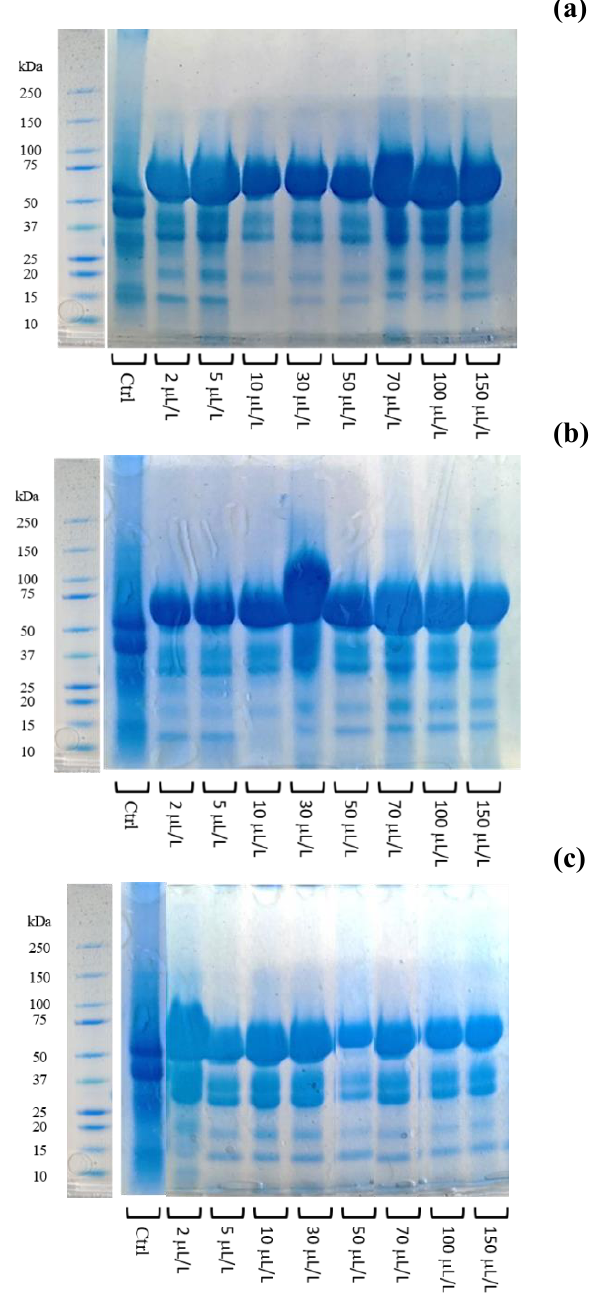
Figure 6. Electrophoretic profile under denaturing conditions of white must-wine subjected to enzymatic addition (protease in the range of 2–150 µ L/L) after ( a ) treatment I (cold settling prior to AF, evaluated at racking after 24 h settling), ( b ) treatment II (at yeast inoculum, evaluated at middle AF) and ( c ) treatment II (at yeast inoculum, evaluated at the end AF). Ctrl is clarified must with the only pectinolytic enzyme.